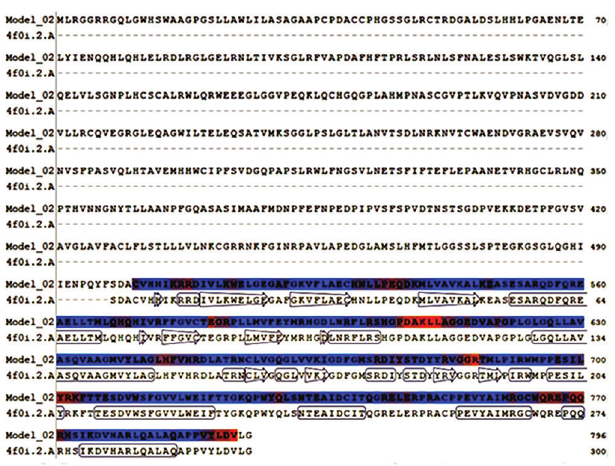
figurE 3 − NTRK1 proto-oncogene – model – template alignment